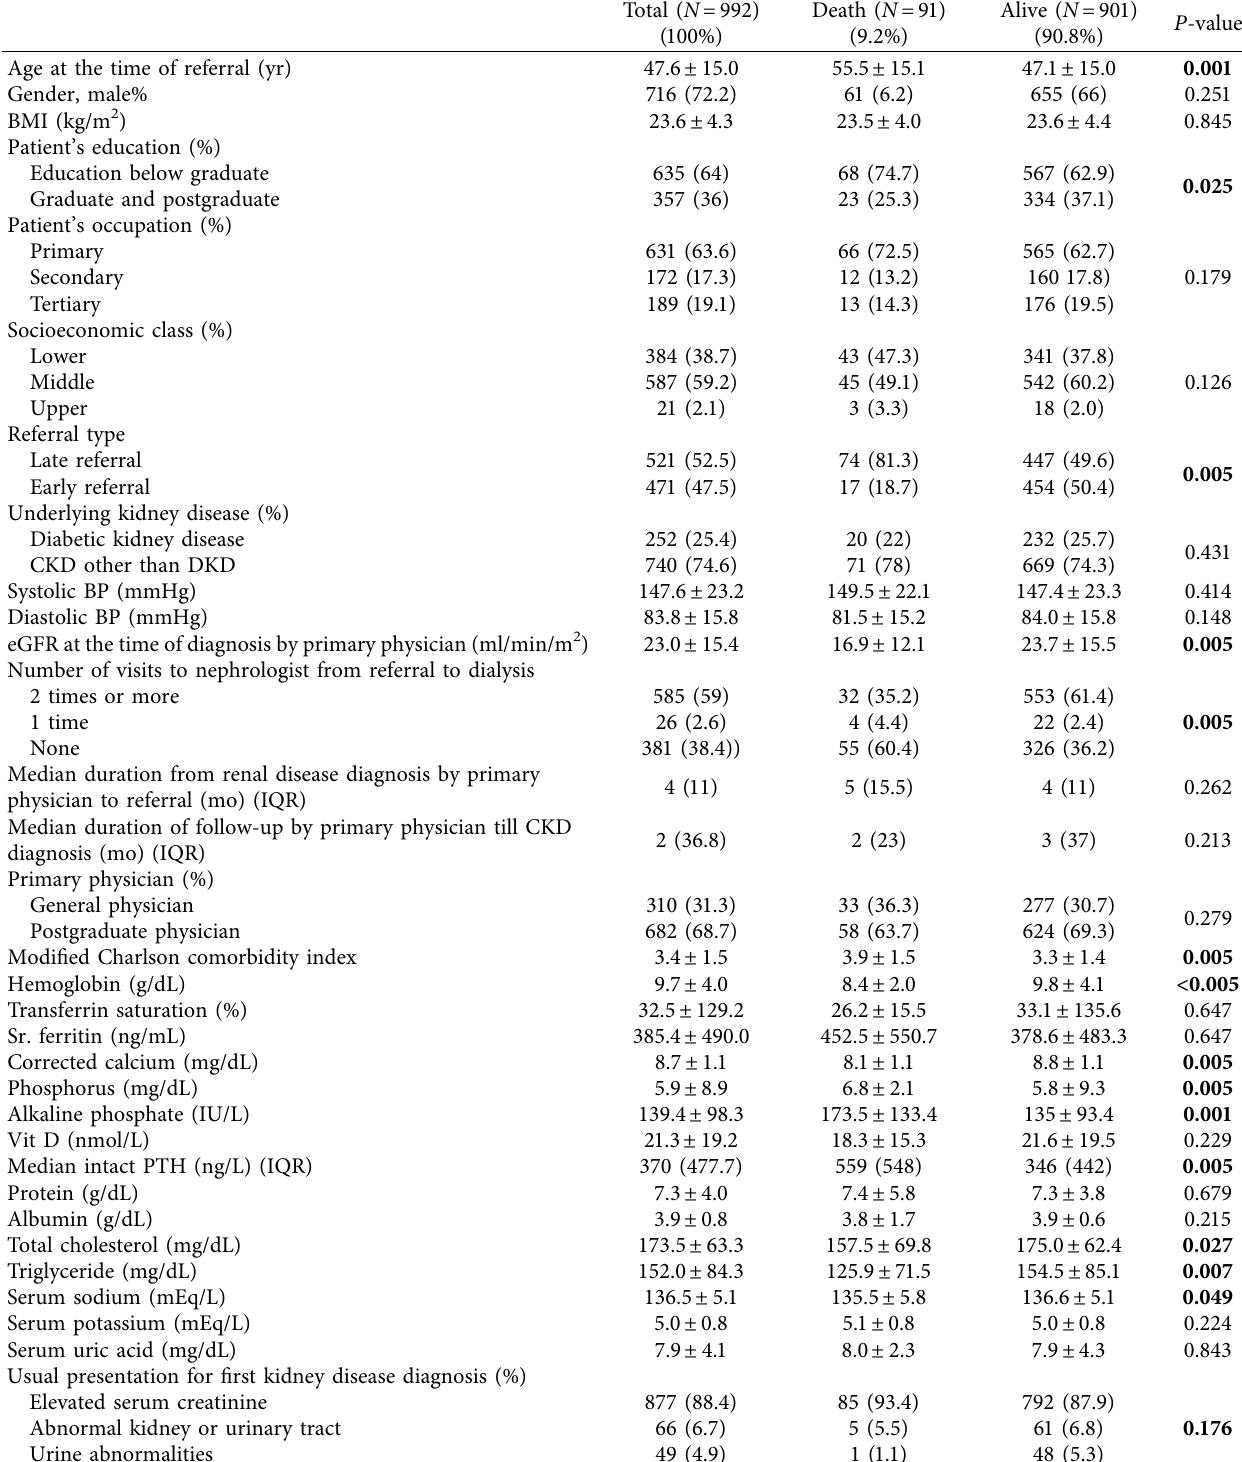
Table 4: Differences in clinical parameters between alive and dead patients on